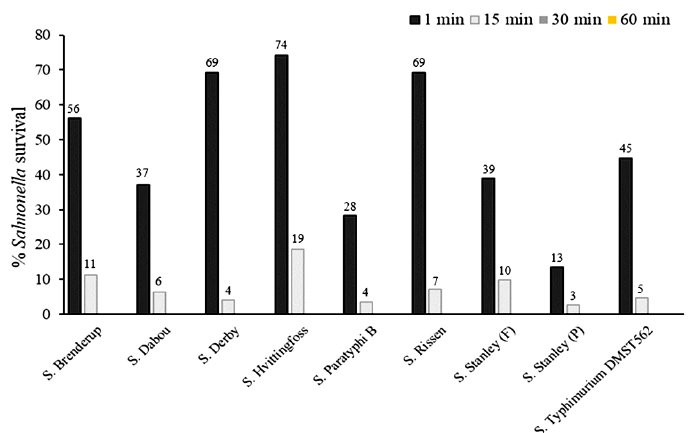
Fig. 2 . Survival of antibiotic-resistant Salmonella serovars after contact with crude P. pentosaceus PS34 CFS for 1, 15, 30 and 60 Table 3. Antibiotic-resistance percentages of Salmonella isolated from vegetables and fermented meats Antibiotics (µg) No. of Salmonella isolates (%) (n=25)